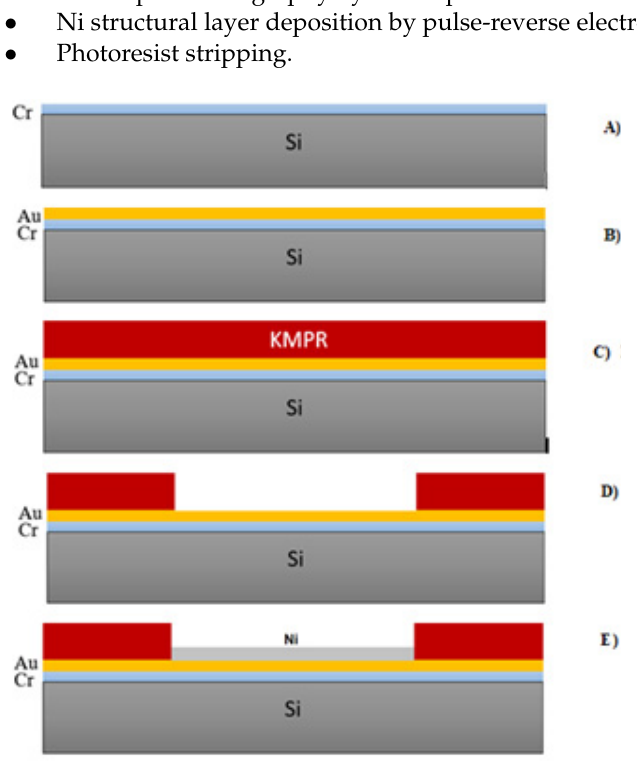
Figure 2. Microfabrication process: ( A ) Sputtering of Cr; ( B ) Sputtering of Au; ( C ) KMPR lithography; ( D ) UV-exposure (patterning); ( E ) Nickel pulse-reverse electroplating.